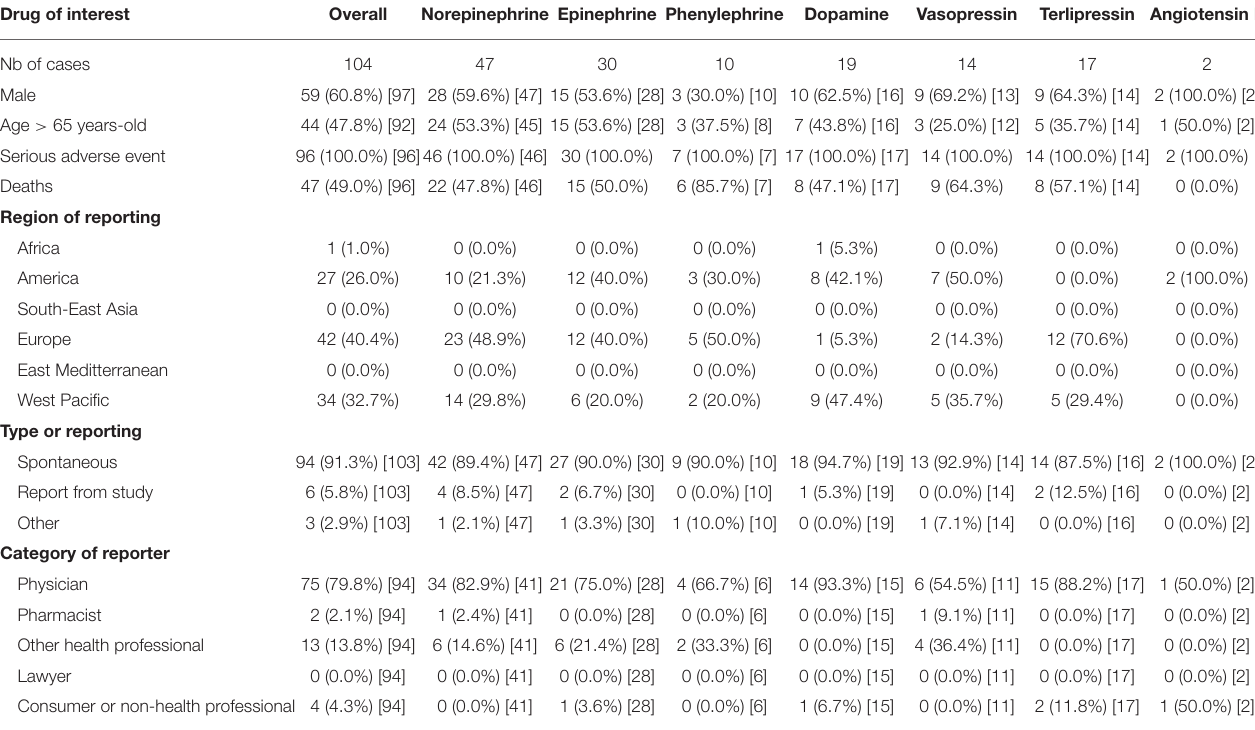
TABLE 1 | Descriptive statistics by molecule of all reports of acute mesenteric ischemia in VigiBase. Drug of